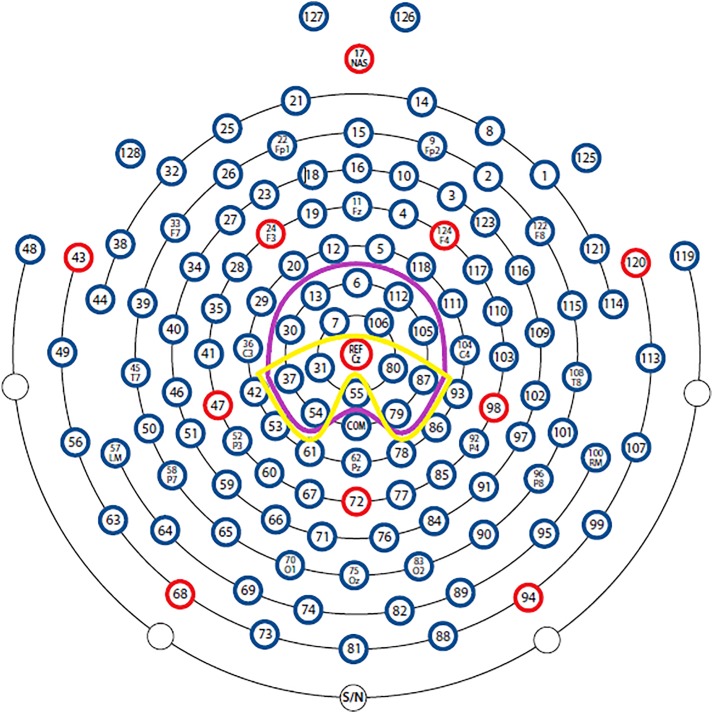
Sensor outline of the HydroCel Geodesic Sensor Net (with permission from Electrical Geodesics, Inc. Electrodes). The LPC and N400 were calculated with the sensors framed with yellow and purple color, respectively.